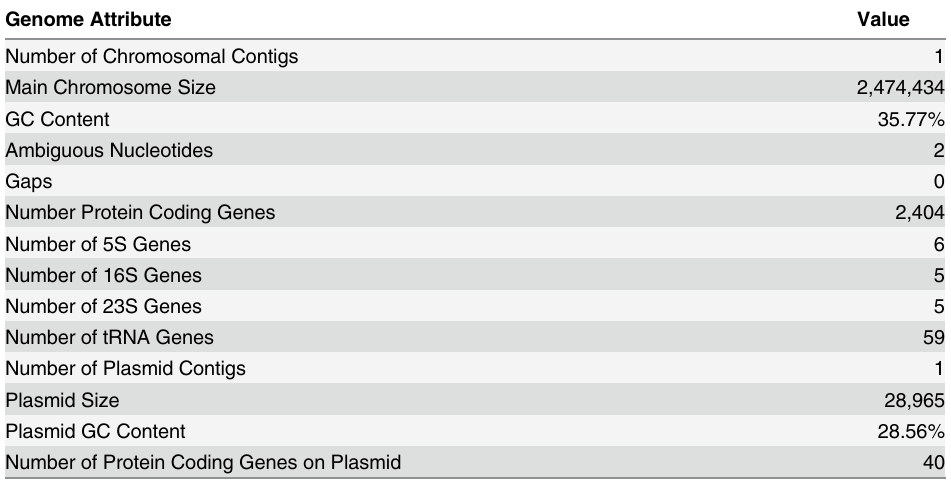
Table 4. Summary data of assembly and annotation of the genome of S . agnetis